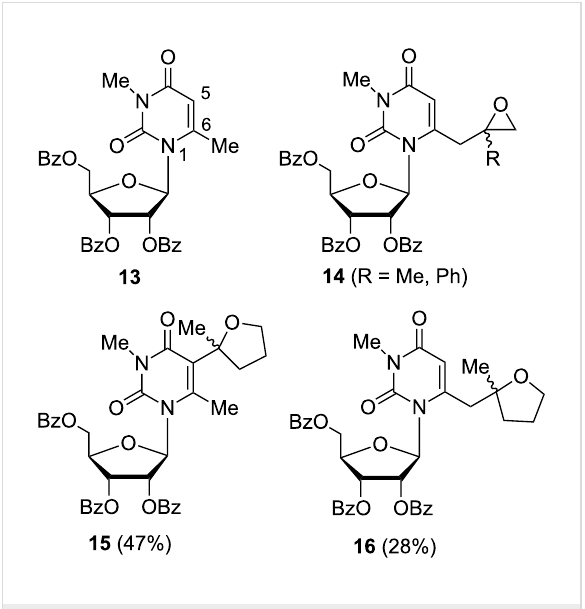
Figure 3: Lithiation/alkylation of 2',3',5'-tri- O -benzoyl-3,6-dimethyluri- dine ( 13 ) using